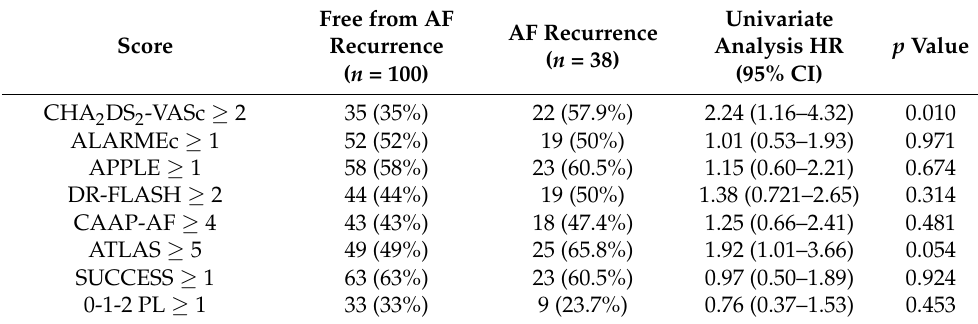
Table 5. Clinical scores